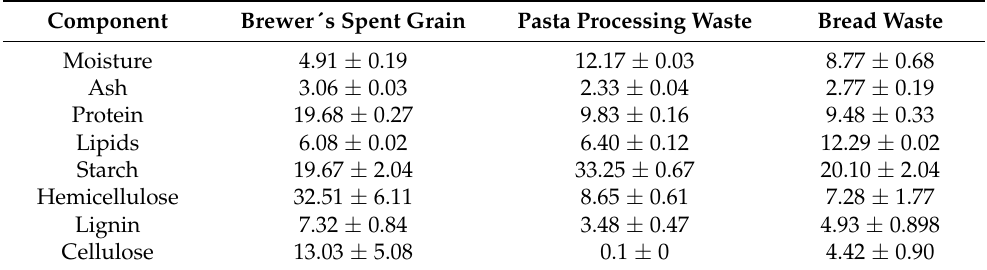
Table 2. Agro-food residues characterization (% w / w , dry weight